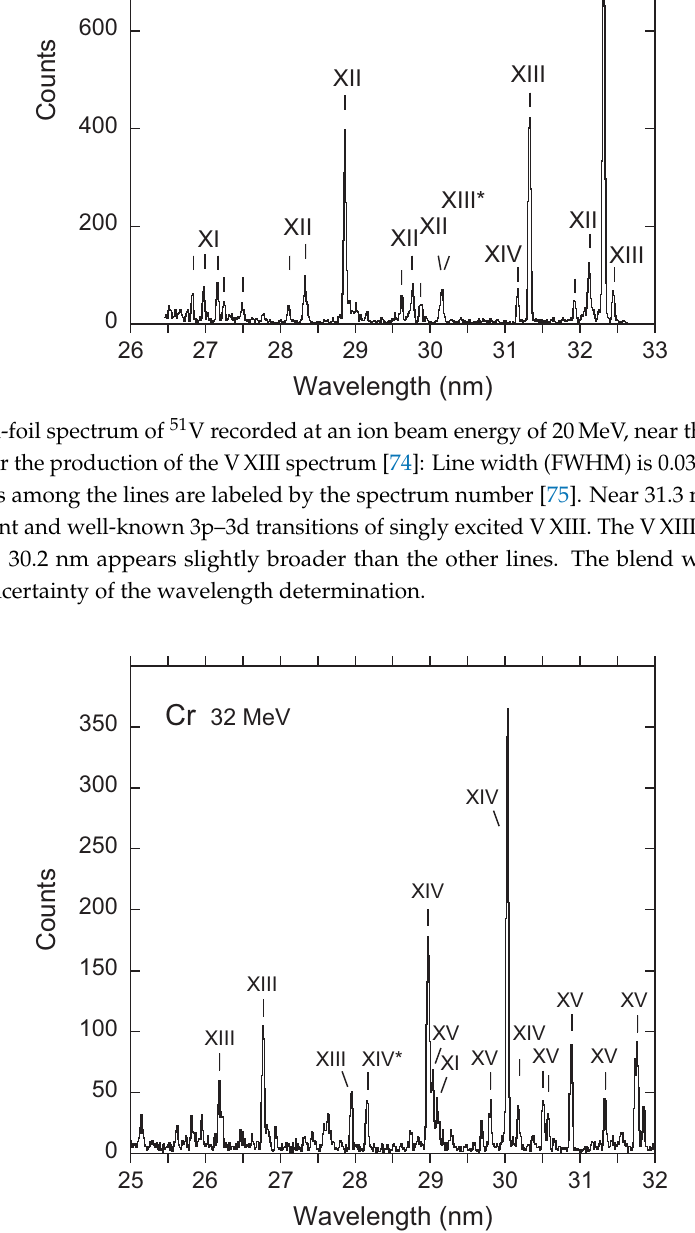
Figure 5. Beam-foil spectrum of 52 Cr recorded at an ion beam energy of 32MeV, near the optimum ion beam energy for the production of the CrXIV spectrum [74]: Line width (FWHM) is 0.035 nm. The more prominent ones among the lines are labeled by the spectrum number [75]. Near 29 nm and 30 nm lie the prominent and well-known 3p–3d transitions of singly excited CrXIV. The shortest-wavelength line of this multiplet suffers from a blend with Cr XI and possibly other lines, which affects the reliability of the wavelength determination of this calibration line. The CrXIV* line of present interest lies at λ ≈ 28.2